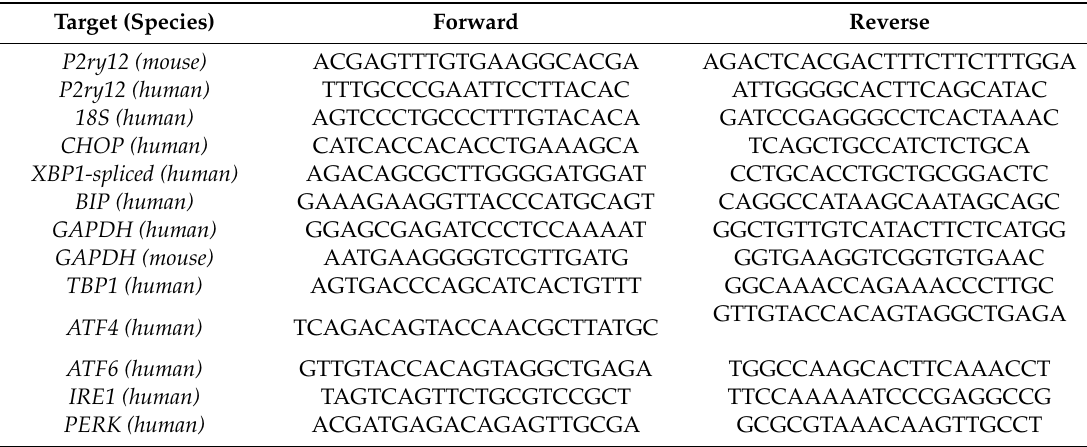
Table 1. Primer sequences used for